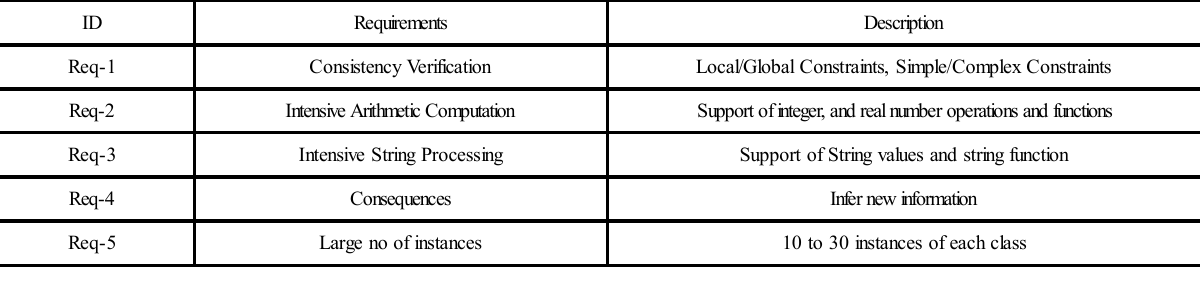
TABLE 1. SUMMARY OF REQUIREMENTS